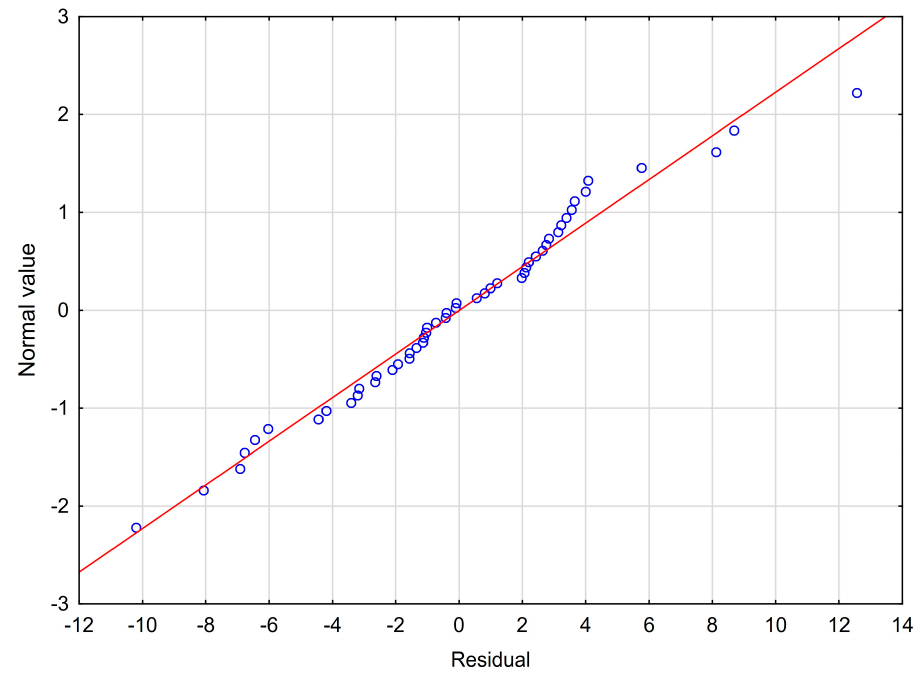
Figure 2. Normality of the distribution of residuals with respect to multiple linear regression model for PSS − 10 estimation.